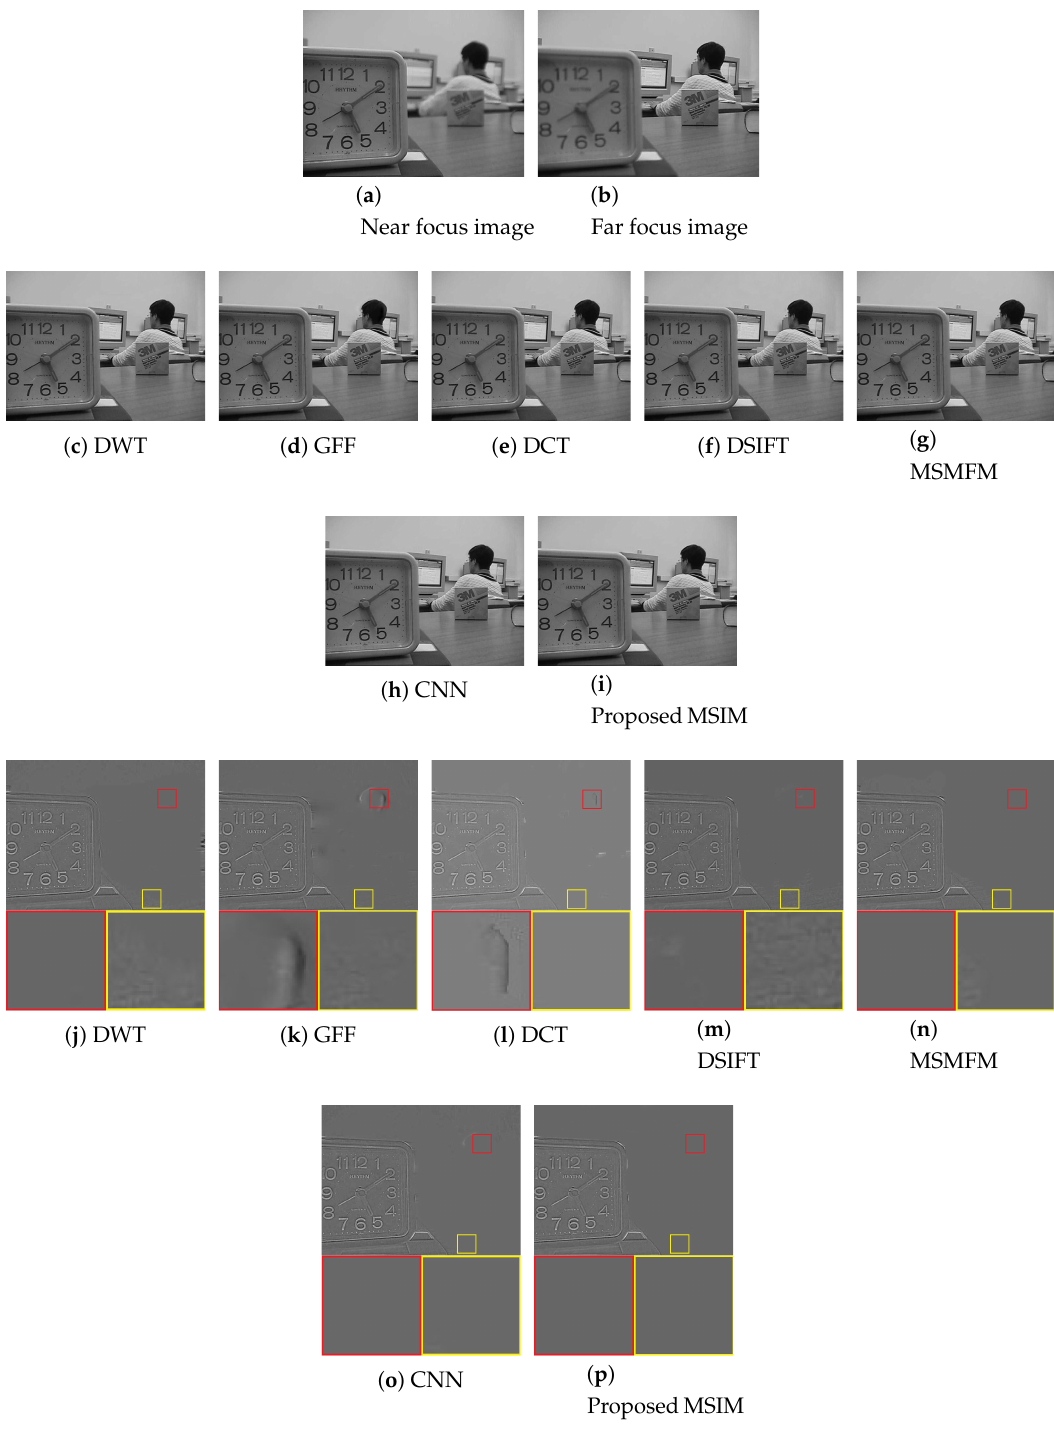
Figure 4. Results of image fusion and their difference images on the “Lab” source images. ( c – i ) Fused images obtained through fusion schemes. ( j – p ) Difference images obtained from the fusion results and Figure